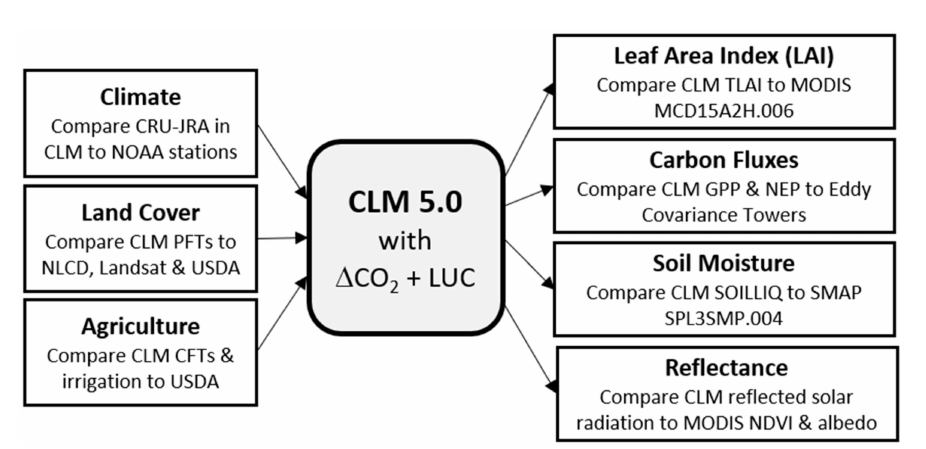
Figure 2. Process diagram of CLM data input (left) and output (right) comparisons made in this study. All abbreviations are defined in the